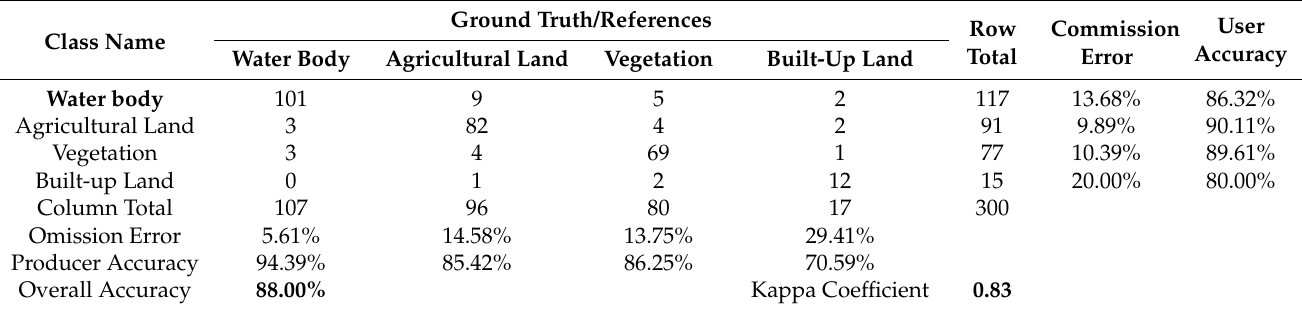
Table 7. Accuracy assessment and kappa coefficient in the year of 2010.